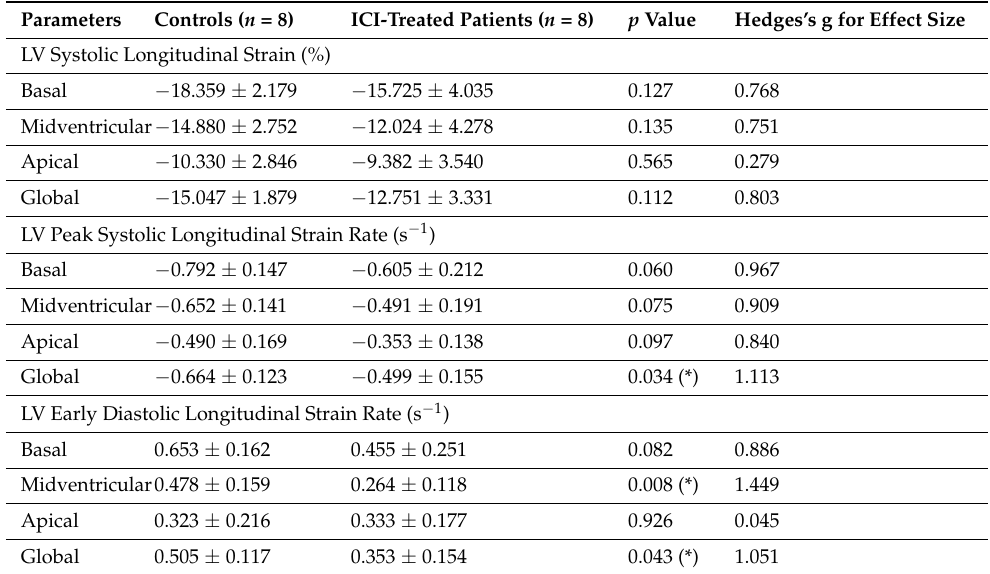
Table 7. Left ventricular (LV) strain and strain rate characteristics of immune checkpoint inhibitor (ICI)-treated patients compared to the controls using cardiac